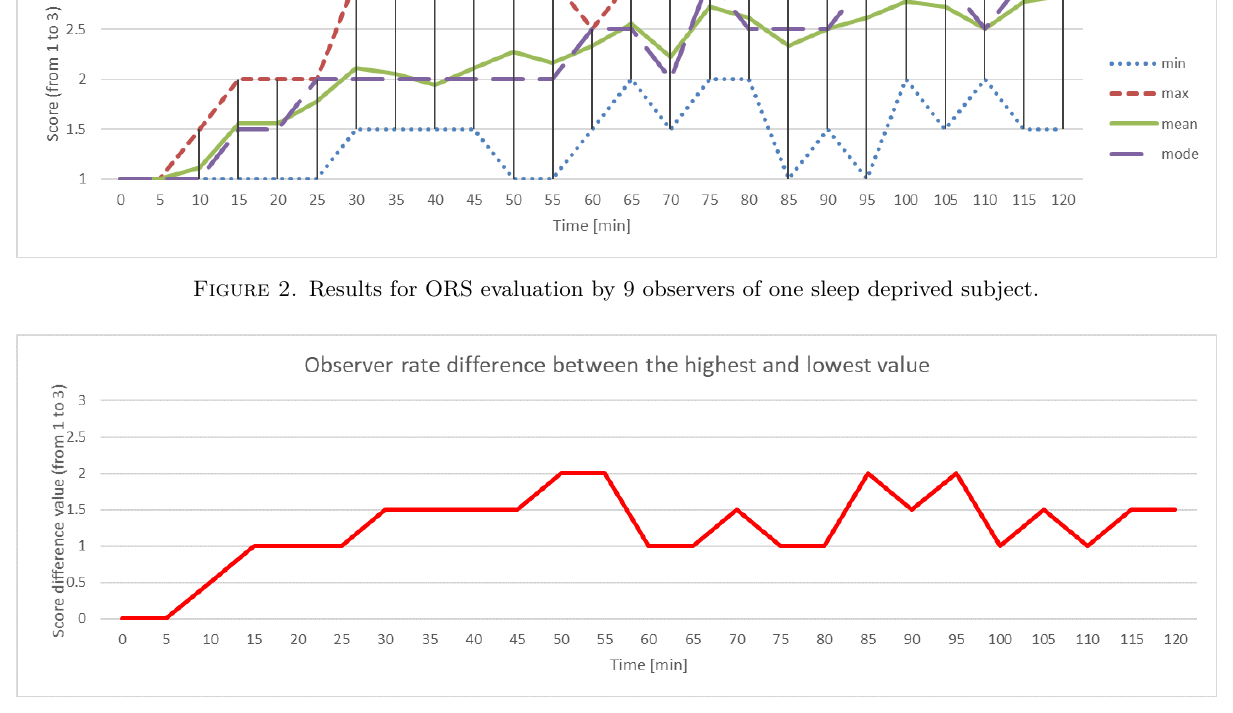
Figure 3. Difference between maximum and minimum rates provided by